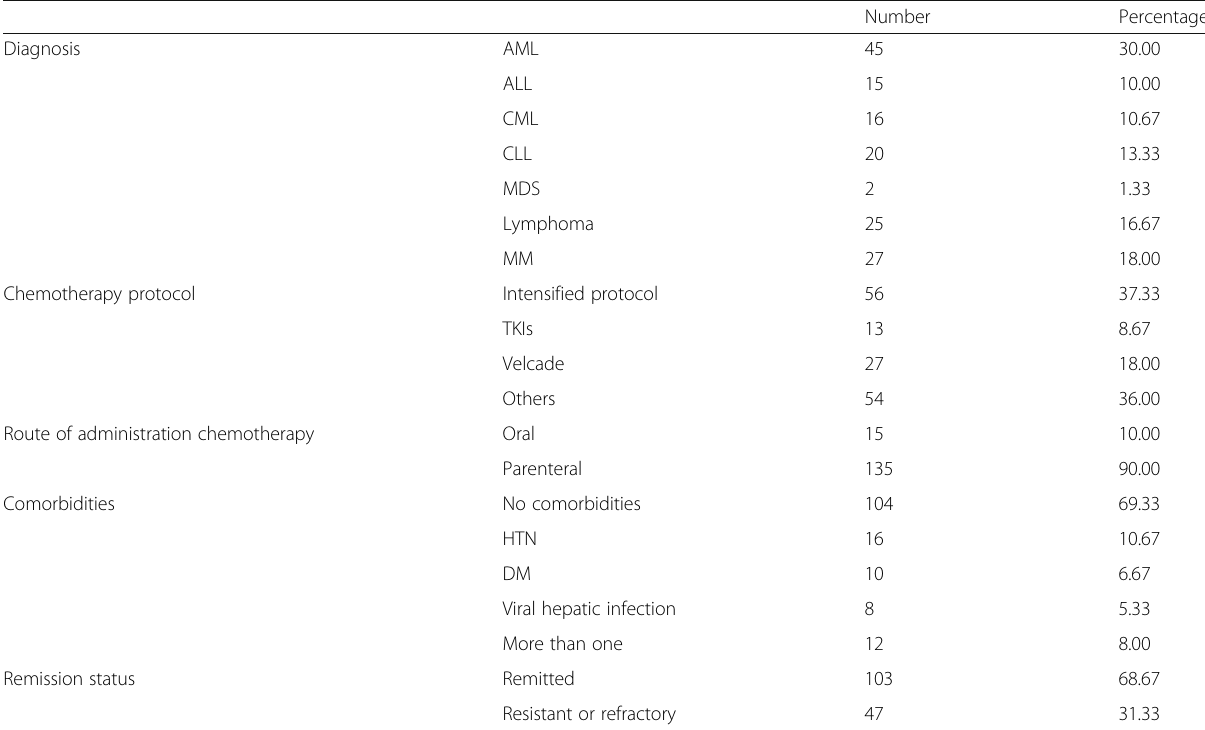
Table 1 Demographic and clinical characteristics of all participants of the study